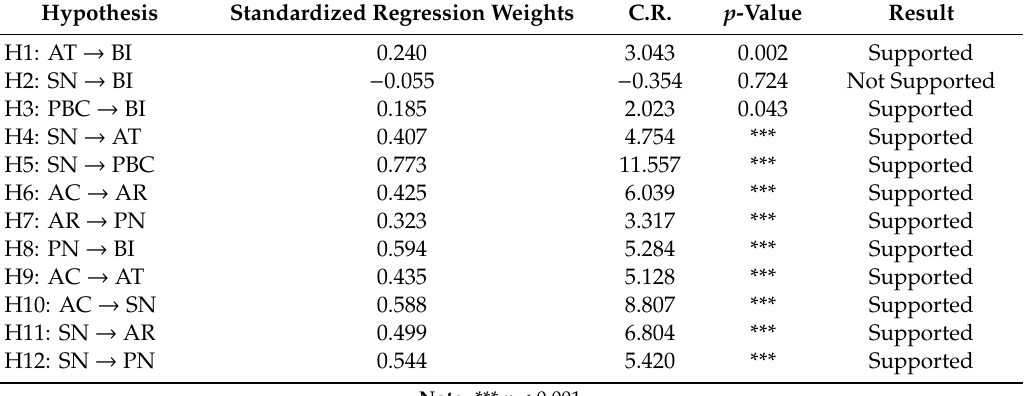
Table 4. Structural equation modeling (SEM) estimation results.